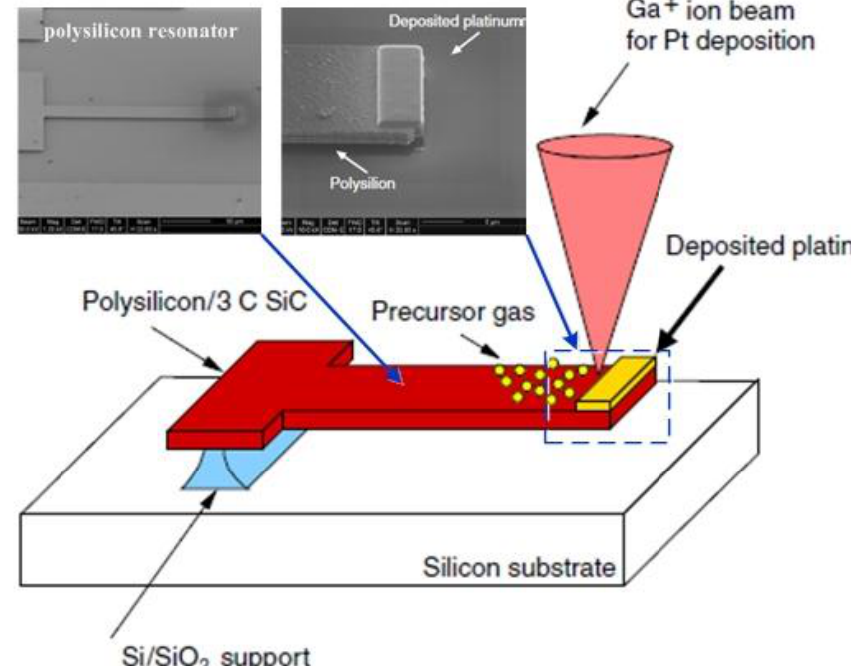
Figure 33. Frequency tuning of resonators by FIB Pt deposition reported by Enderling et al . [36]. Reused with permission from IOP